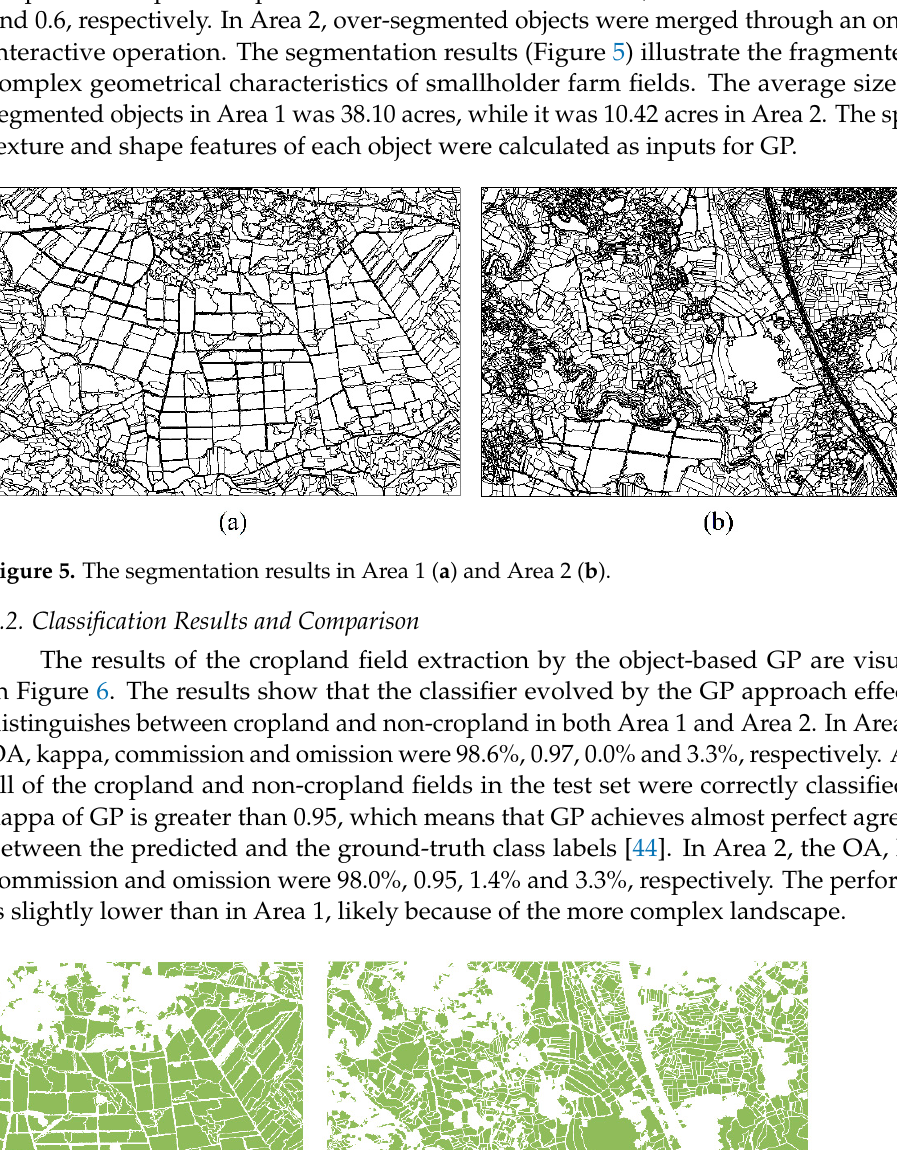
Figure 4. The results of the estimation of scale parameter (ESP) tool in Area 1 ( a ) and Area 2 ( b ). The black vertical dashed lines indicate the selected scale parameters of Area 1 and Area 2.